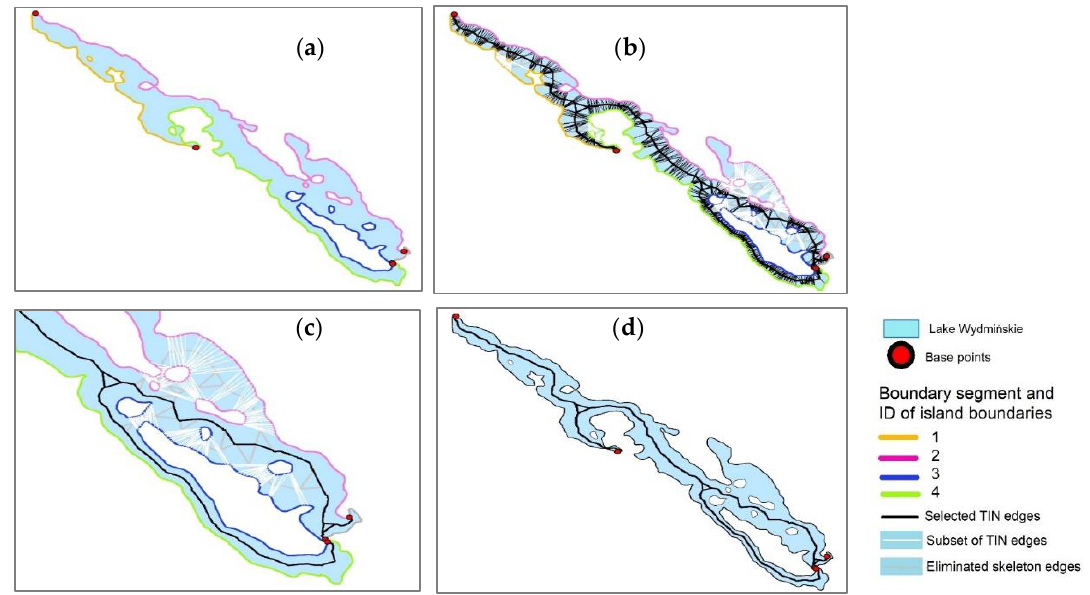
Figure 25. Modification of the base skeleton to obtain a skeleton in the center of the polygon between islands: ( a ) island boundaries are assigned new identifiers, and the resulting changes are marked in color; ( b ) a subset of TIN edges for modifying the skeleton is marked in white; ( c ) elimination of skeleton edges that touch TIN edges; ( d ) the resulting skeleton.